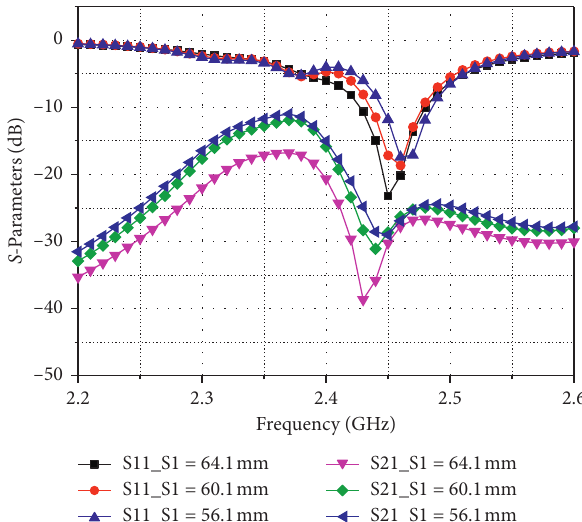
Figure 4: Relationship between the S -parameter and S